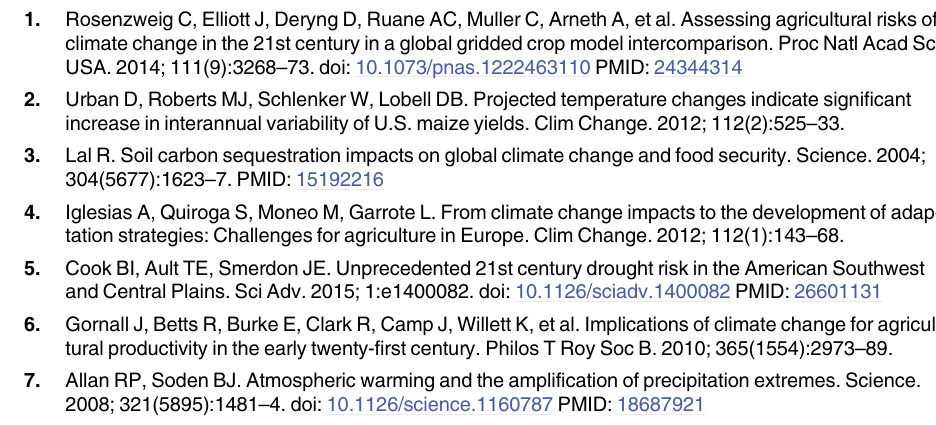
S4 Fig. BLUPs (best linear unbiased predictors) from linear mixed effects model quantify- ing state-level associations between two measures of maize yield stability: CV (coefficient of variation) and POLAR (Power Law Residuals). Fixed effects: intercept = 0.17 (t 10.3, P < 0.0001), POLAR = 0.18 (t = 8.2, P < 0.0001). Random effects: standard deviation 1, 232 (POLAR) = 0.023, standard deviation (residual) = 0.04. Number of observations, by state: = 84, N = 47, N = 52, N = 56. N IL MI MN PA S1 Table. Pearson correlations between county-level indices of maize yield stability and drought and selected soil and site properties in four maize-producing US states.